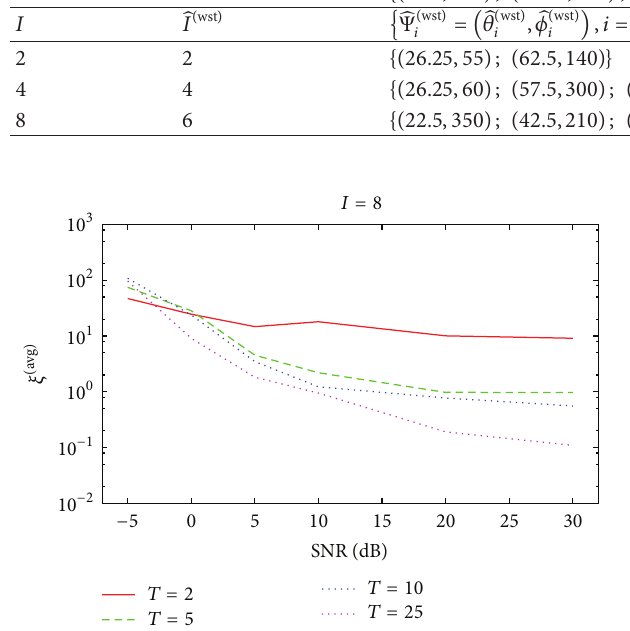
Figure 6: Fully populated array—( 𝑁 = 25 ; 𝑑 𝑥 = 𝑑 𝑦 = 0.5𝜆 ; 𝐼 = 8 ; SNR ∈ [−5 : 30] dB; 𝑇 ∈ [2 : 25] ; 𝐶 = 50 )—behavior of the location index 𝜉 ( ave ) averaged among 𝐶 different noisy scenarios versus the SNR when using the MT-BCS with different number of available snapshots 𝑇